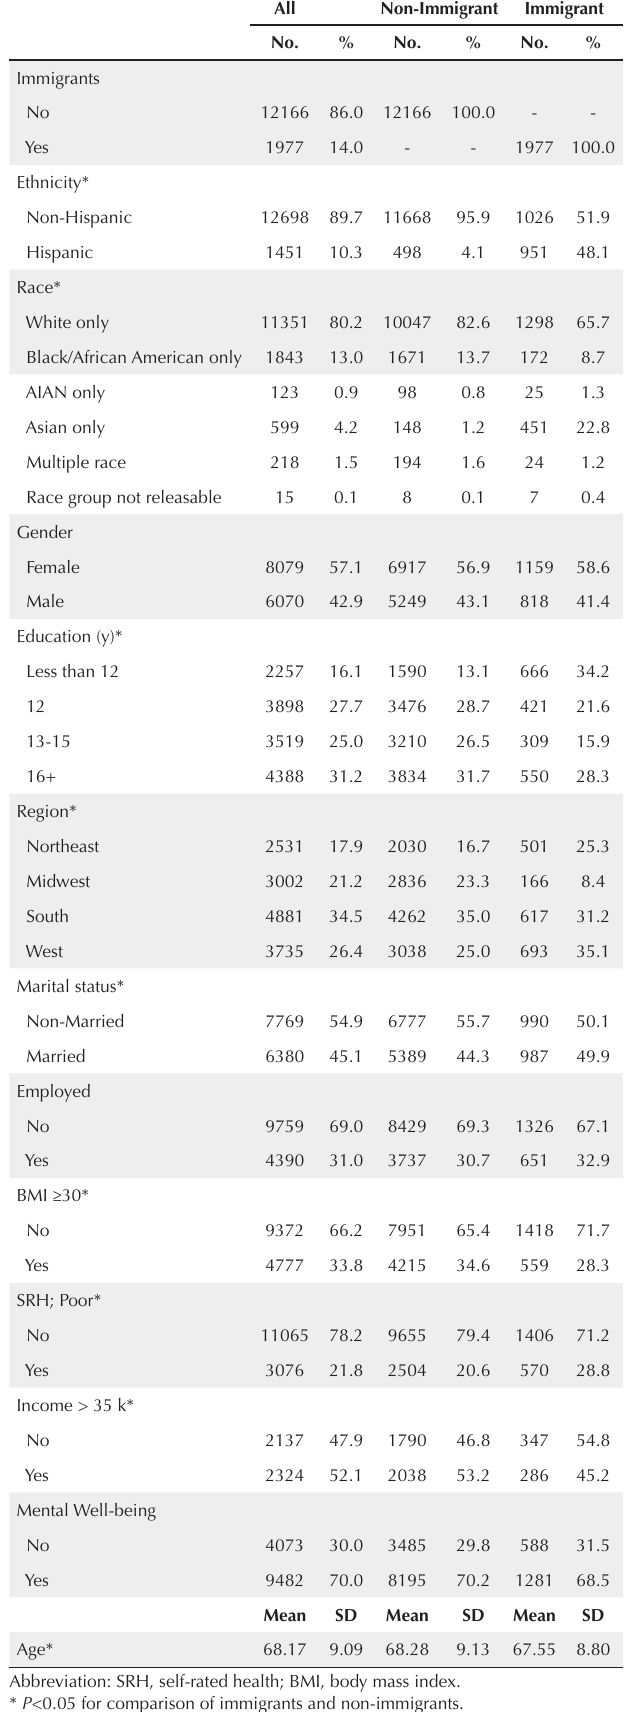
Table 1. Descriptive Statistics Overall and Based on Immigration (n=14 149)